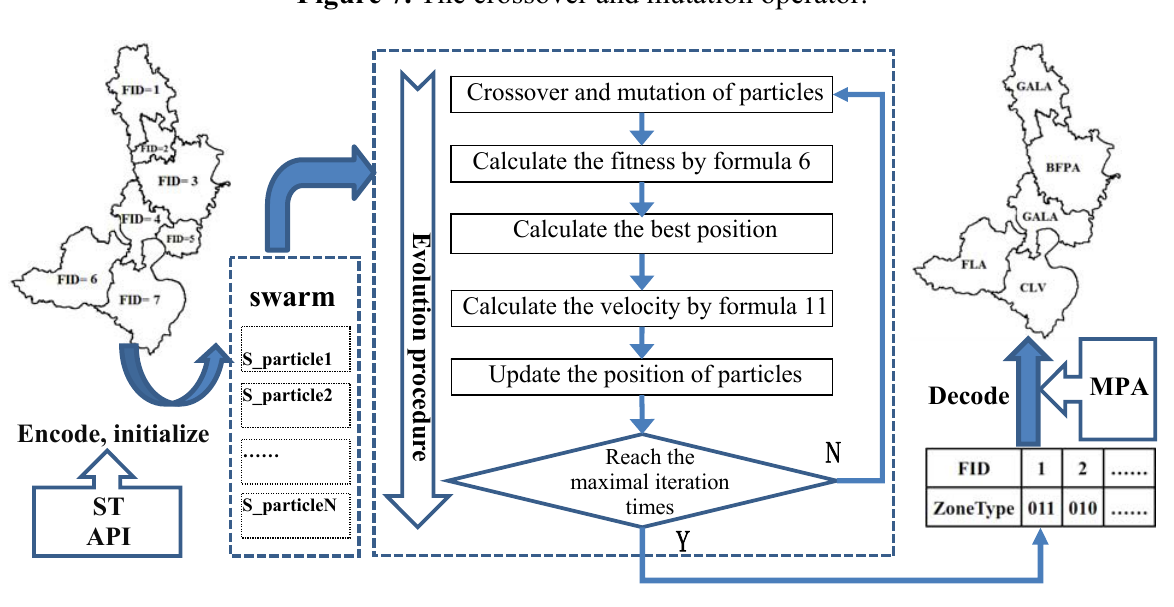
Figure 7. The crossover and mutation